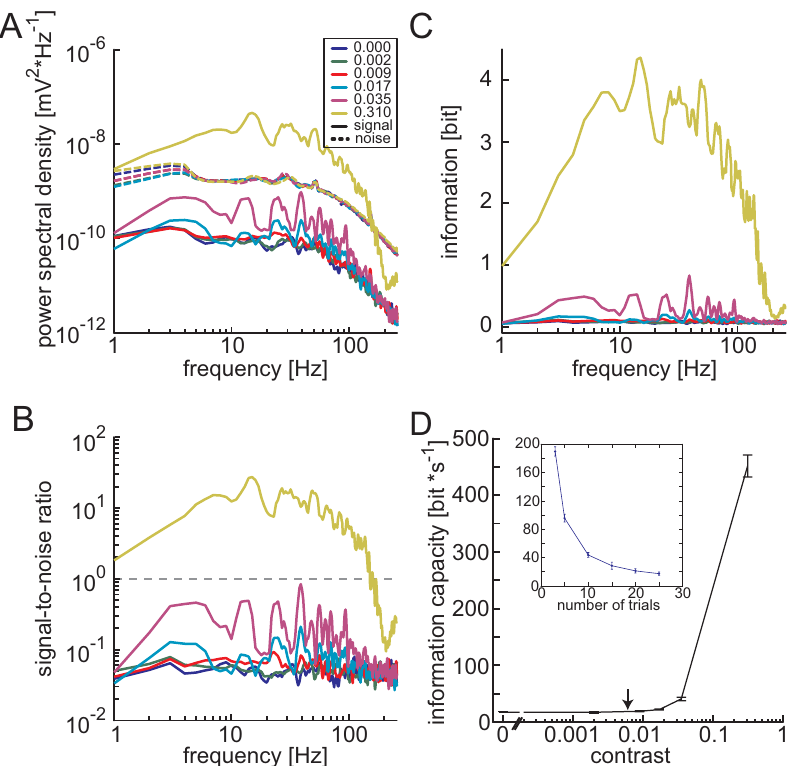
Figure 2. Information theoretical analysis. A S(f), the power spectral density of the signal (mean response, solid lines), and N(f), the power spectral density of noise (dashed lines), normalized to the signal or noise mean square amplitude. The inset assigns different colors to the different stimulus contrasts. B Signal-to-noise ratios at the six different contrasts used (same color code as in A). Dashed line indicates SNR of 1. C Shannon information as function of frequency at different contrasts (same color code as in A). Information estimated from signal-to-noise ratio as: log 2 [1 + S(f)/N(f)]. All spectra were smoothed using a 4 point running average. D Shannon information capacity as a function of contrast; average 6 95% confidence interval (N=12). At the 0.31 contrast 14 additional cells were analyzed. Abscissa is interrupted to display zero contrast on the logarithmic scale. Arrow marks the contrast induced by photon shot noise at the mean light intensity. Inset shows the dependence of the information capacity on the amount of data analyzed. The information capacities shown were calculated at zero contrast by using different numbers of trials to estimate the SNR.